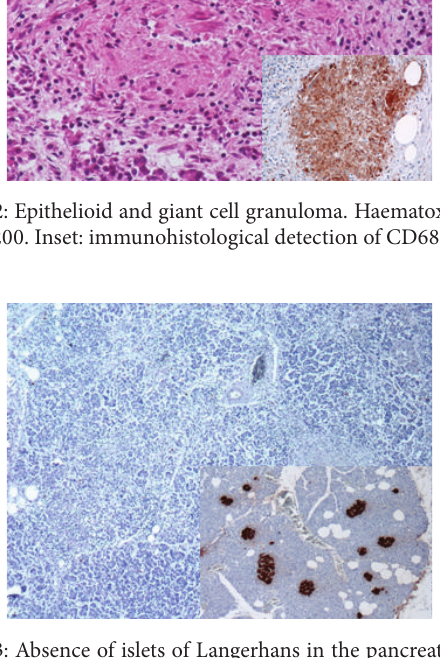
Figure 3: Absence of islets of Langerhans in the pancreatic tissue. Immunohistological detection of insulin, × 40. Inset: density of islets of Langerhans in normal (control) pancreatic